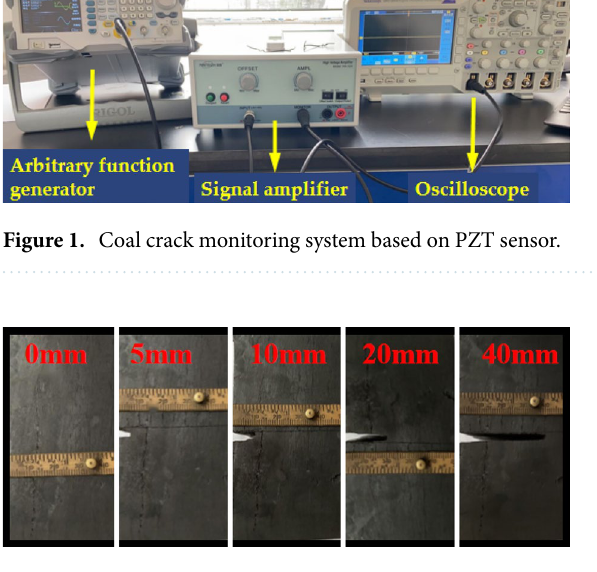
Figure 2. The coal samples